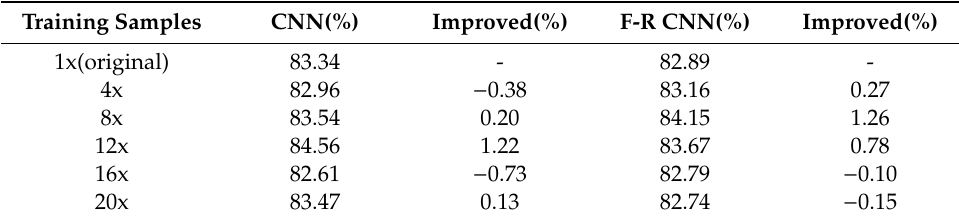
Table 5. Classification accuracy with increasing number of training